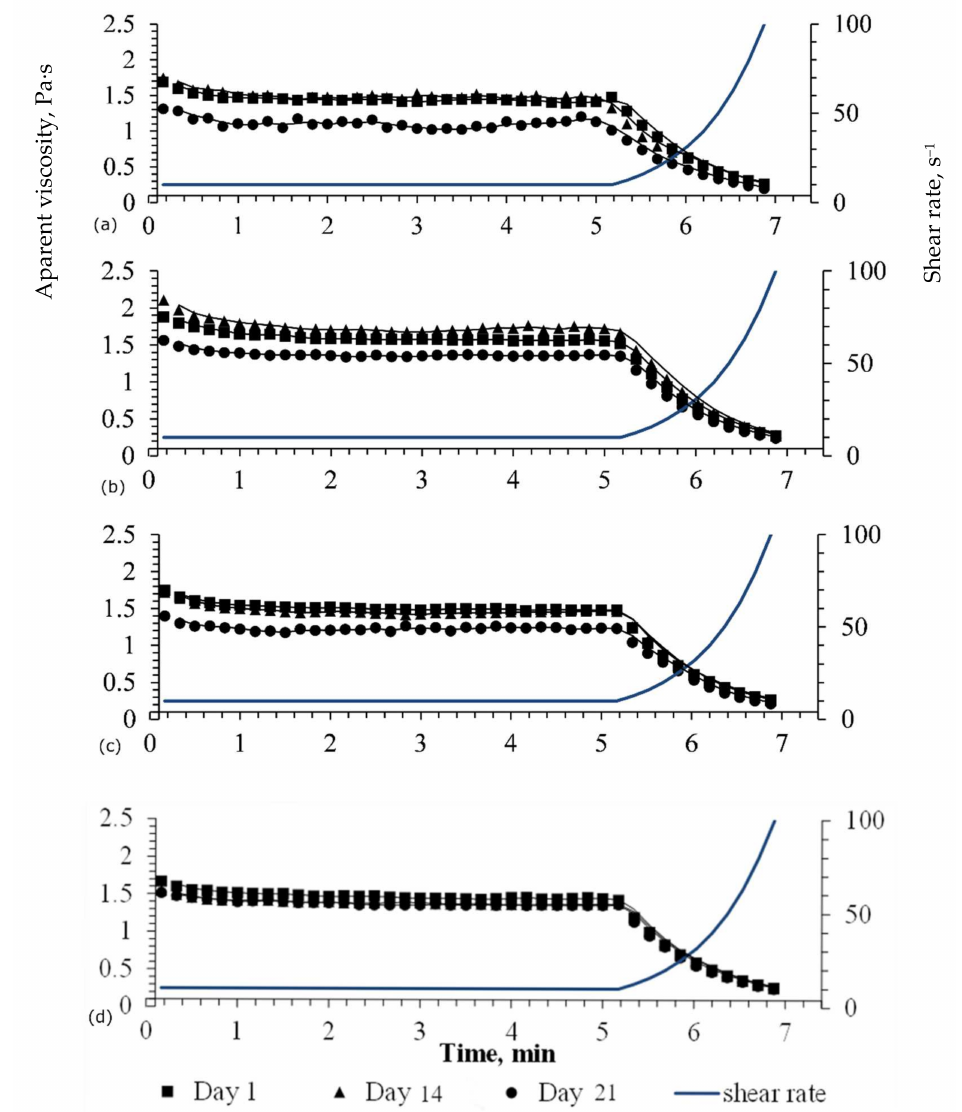
Figure 2. The effect of processing on rheological behavior of peach–strawberry puree. ( a ) Control; ( b ) TT (70 ◦ C, 15 min); ( c ) HPP (600 MPa, 10 min); ( d ) HPMT (600 MPa, 50 ◦ C, 10